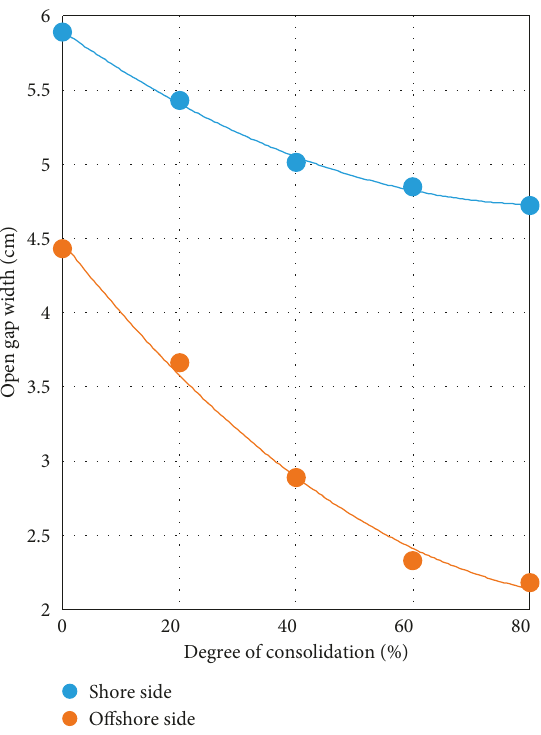
Figure 21: Variation rules for open gap of the sluice box culvert and